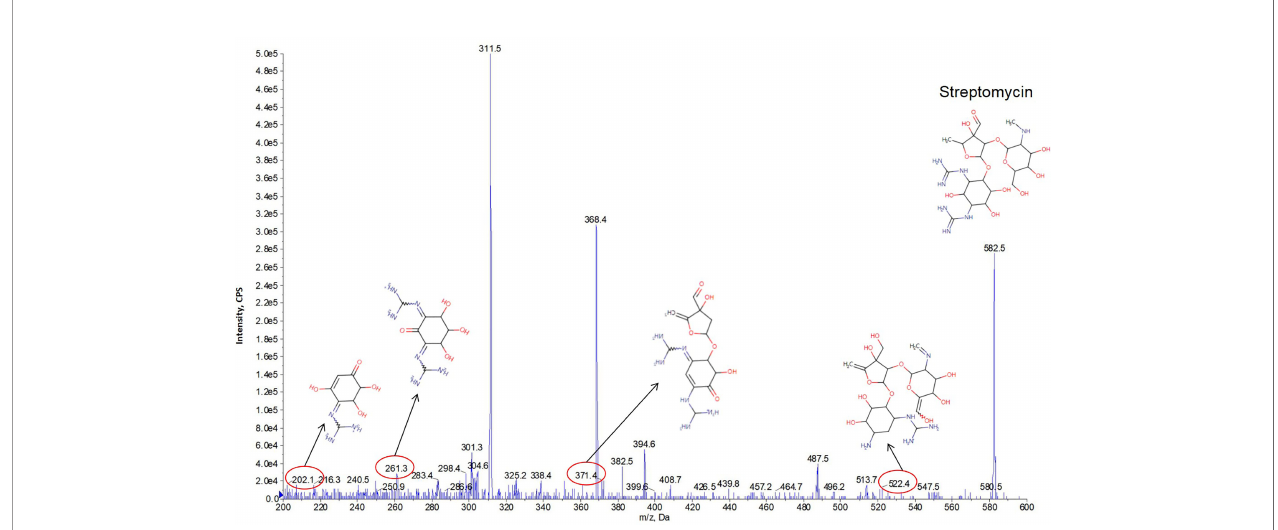
FIGURE 4 | The in-source fragments from streptomycin (m/z 582.5) at m/z 202.1, 261.3, 371.4 and 522.4 were identi fi ed in the secondary scan mode by MS/MS